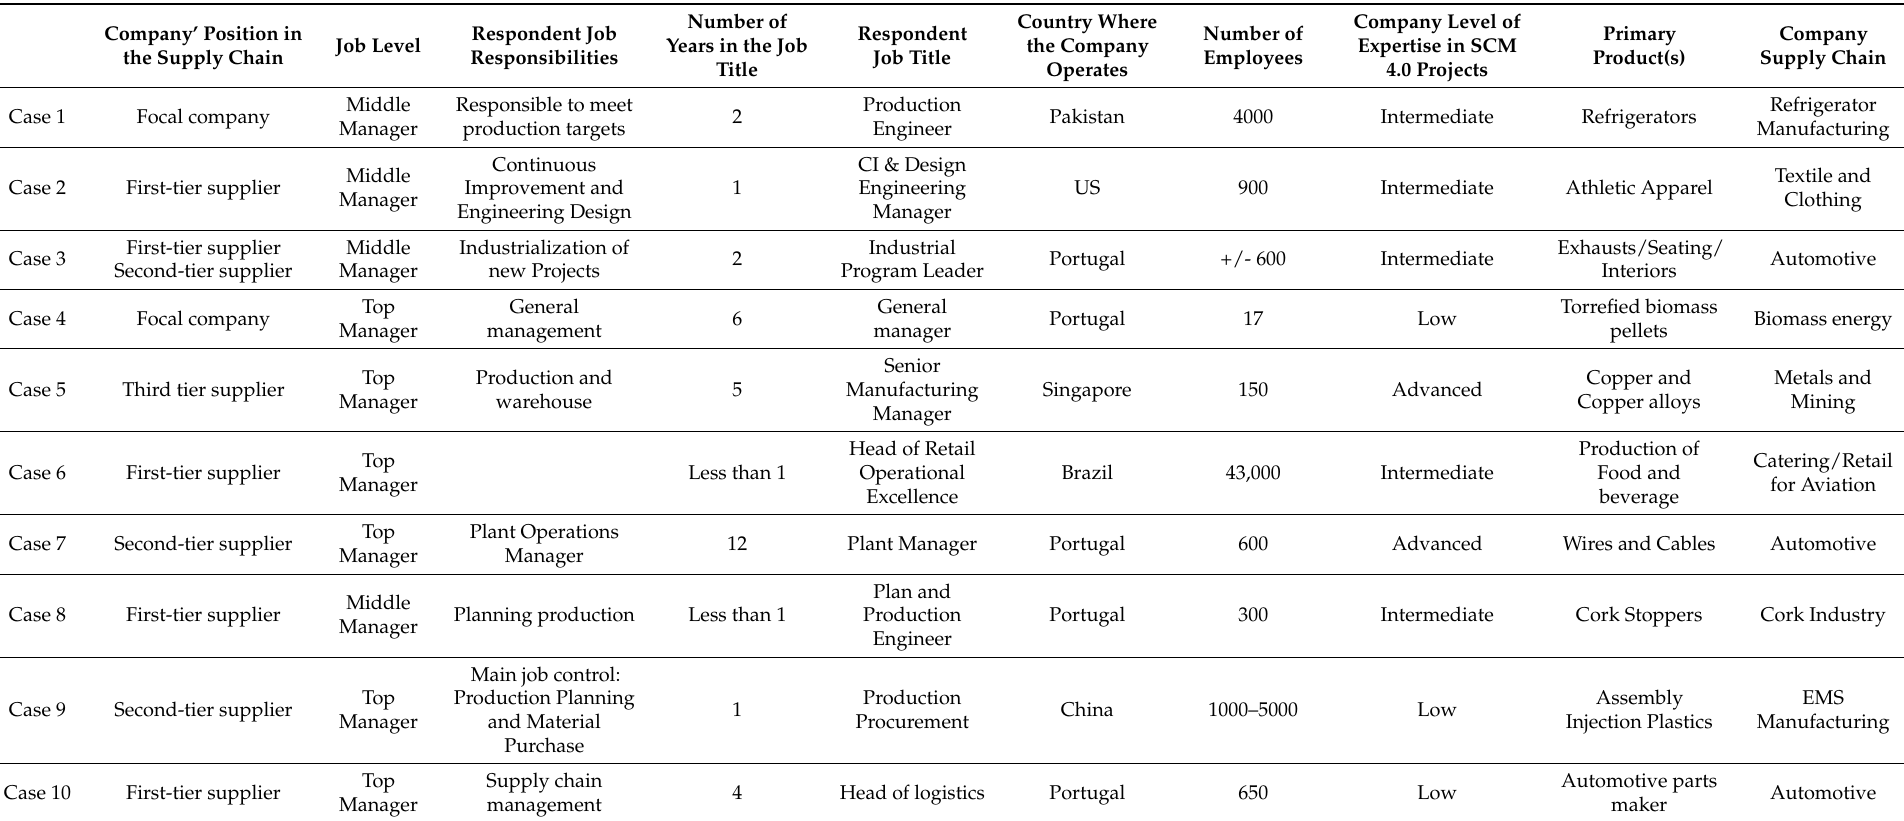
Table 3. Case Studies